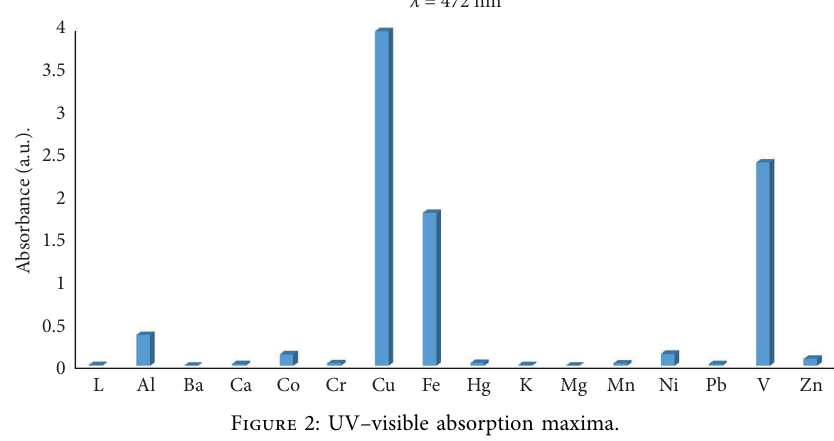
Figure 2: UV–visible absorption